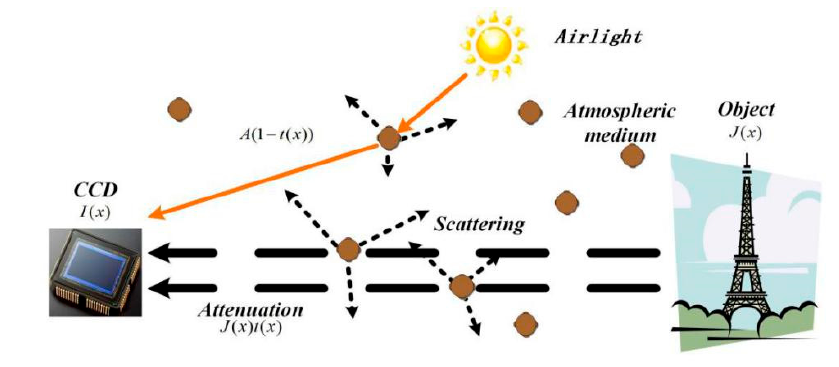
Figure 1. Degradation model.